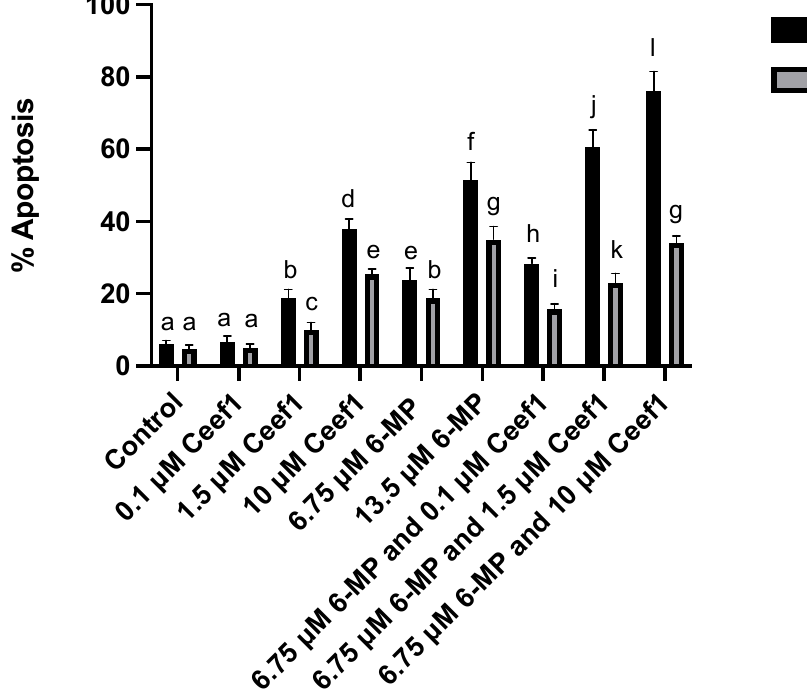
Figure 6. Individual treatments of 6-MP and Ceef1 and their respective combinations in both, Jurkat cells and CRL-1991 cells to test apoptosis induction. Mean +/ − SE are shown in each column. Significant differences between groups are represented as different letters ( p -value ≤ 0.05), according to two-way ANOVA and Bonferroni´s multiple comparison test.